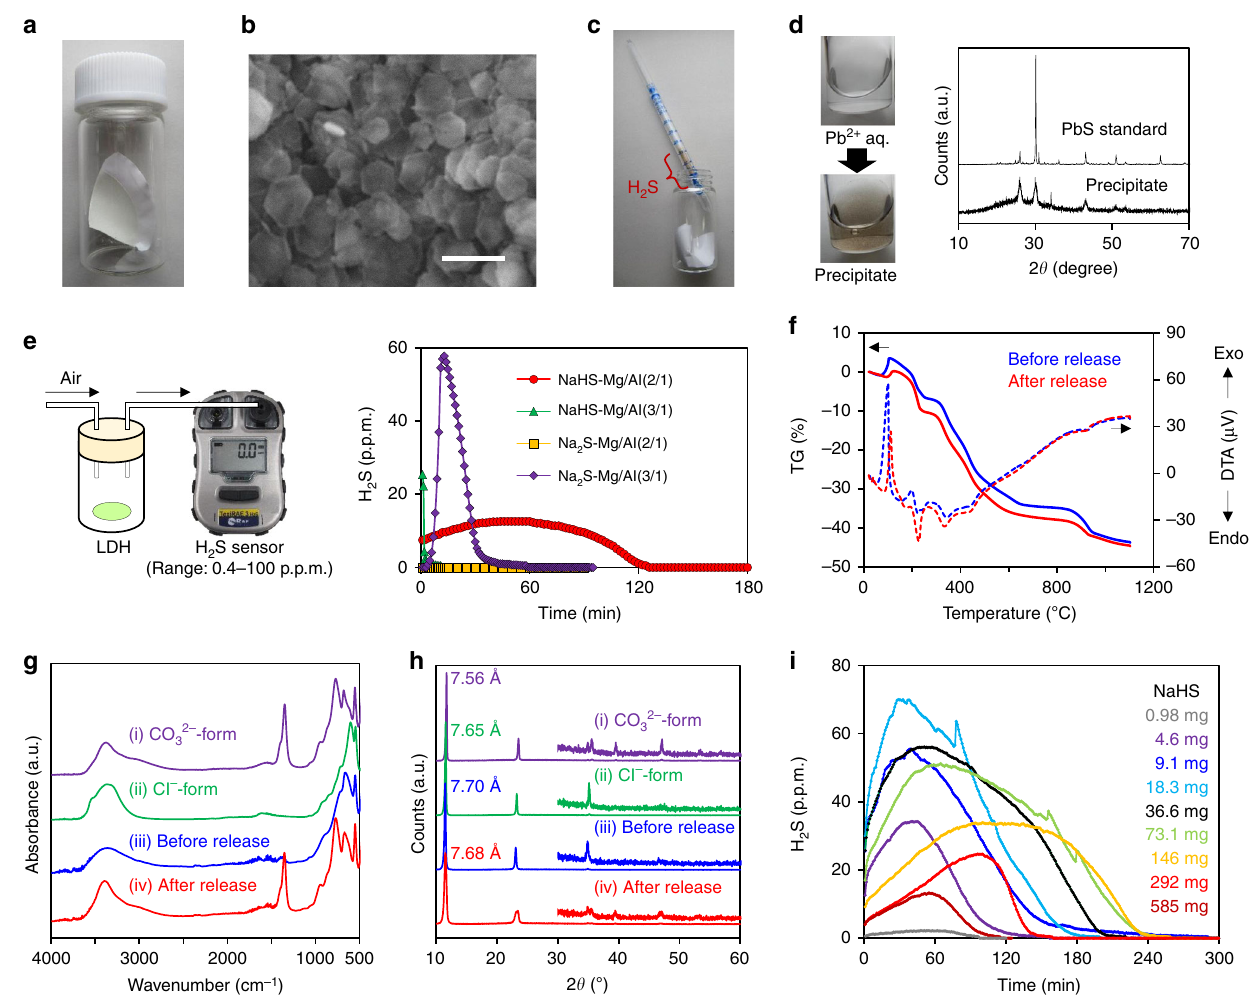
Fig. 2 Characterization of H 2 S-releasing layered double hydroxides. a Photograph of NaHS-Mg/Al(2/1) embedded on membrane fi lter (stored in the glass vial purged with dry N 2 ). b SEM image of NaHS-Mg/Al(2/1) after H 2 S release (scale bar: 2 μ m). c H 2 S release from NaHS-Mg/Al(2/1) con fi rmed by detector tube. d Powder XRD pattern of black precipitate obtained by reaction of aqueous Pb 2 + with released gas. e Continuous monitoring of H 2 S released from LDHs under standard fl ow condition; 0.020 mmol of LDHs (5.0 mg of Mg/Al(2/1) and 6.25 mg of Mg/Al(3/1)) were tested. Thermogravimetry- differential thermal analysis (TG-DTA) pro fi les ( f ), IR spectra ( g ), and powder XRD patterns ( h ) of NaHS-Mg/Al(2/1) before and after H 2 S release. For comparison, IR and XRD data of starting materials are also shown. i Optimizing amount of NaHS ∙ n H 2 O used in preparing NaHS-Mg/Al(2/1) from 40 mg of Cl − -type LDH; 20 mg of LDH was tested under standard fl ow